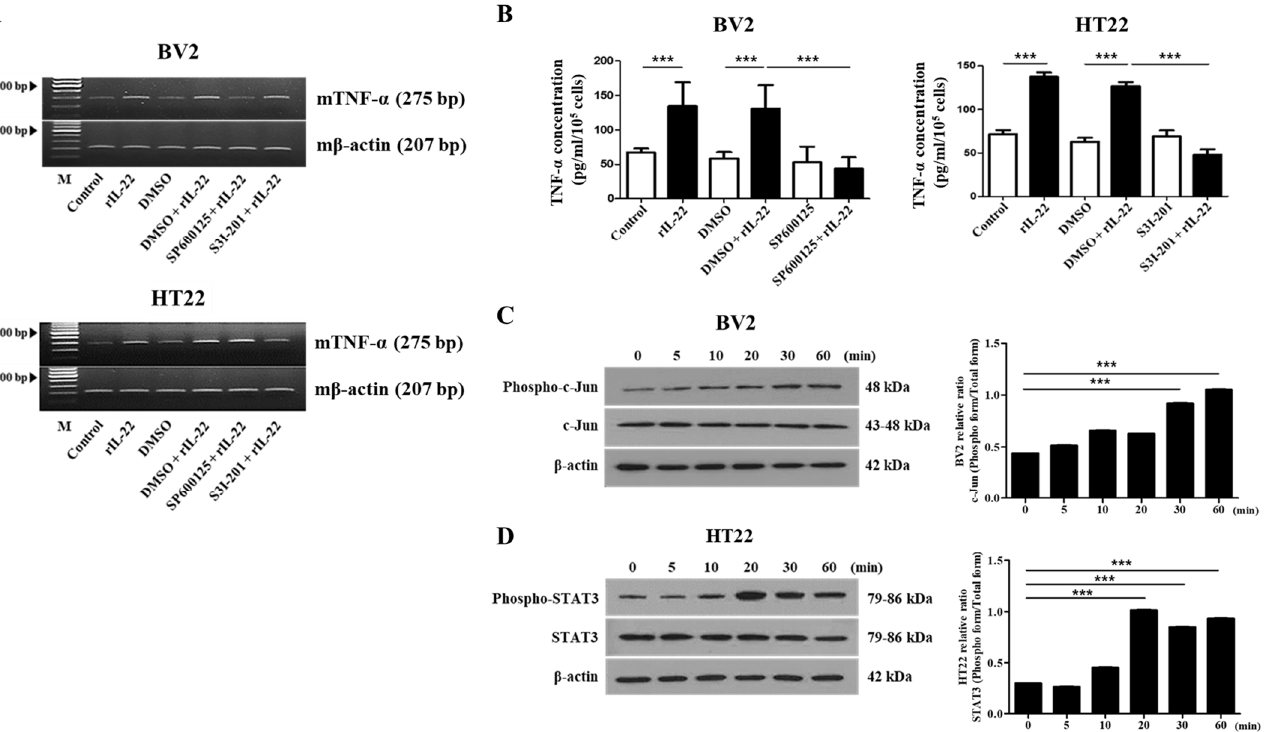
Figure 3. The JNK and STAT3 signaling pathways play an important role in IL-22-mediated inflammatory cytokine production by BV2 and HT22 cells, respectively. ( A ) RT-PCR analyses of TNF- α in cells that were pretreated with DMSO (vehicle control), SP600125 (20 µM), and S3I-201 (50 µM) for 1 h prior to treatment with IL-22 (20 ng/mL) for 12 h. ( B ) ELISA-based analysis of TNF- α in the supernatants of cells that were pretreated with DMSO (vehicle control), SP600125 (20 µM), or and S3I-201 (50 µM) for 1 h prior to treatment with IL-22 (20 ng/mL) for 48 h. *** p < 0.001. ( C ) Immunoblot analyses of c-Jun and phosphorylated c-Jun in BV2 cells that were pretreated with SP600125 (20 µM) and then treated with IL-22 (20 ng/mL) for 0, 5, 10, 20, 30, or 60 min. Relative intensity was analyzed by ImageJ software. All results were representative of at least three independent experiments. Values were presented as the mean ± SD. Significance ( p -value) was determined by t- test, *** p < 0.001. ( D ) Immunoblot analyses of STAT3 and phosphorylated STAT3 in HT22 cells that were pretreated with S3I-201 (50 µM) and then treated with IL-22 (20 ng/mL) for 0, 5, 10, 20, 30, or 60 min. ( A , C , D ) Results are representative of three independent experiments. Relative intensity was analyzed by ImageJ software. All results were representative of at least three independent experiments. Values were presented as the mean ± SD. Significance ( p -value) was determined by t- test, *** p < 0.001.